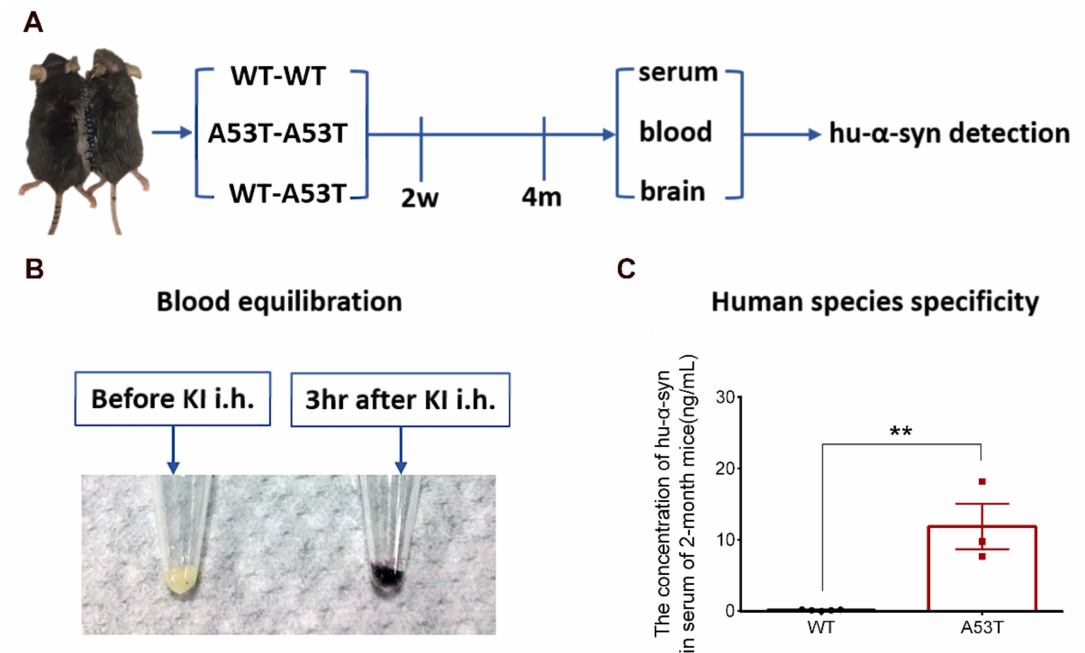
Figure 1. Experimental design and analysis of feasibility. ( A ) Homologous WT-A53T parabiosis group and WT-WT or A53T- A53T sham-operated group mice were surgically joined together. ( B ) Two weeks after the operation, blood equilibration was observed with KI injection. ( C ) No Hu- α -syn was detected in serum of WT mice, while serum of A53T mice contains a large amount of Hu- α -syn. ( n = 5, 3, ** p < 0.01, the specific levels of each sample in different groups were shown as “ • ” and “ (cid:110)